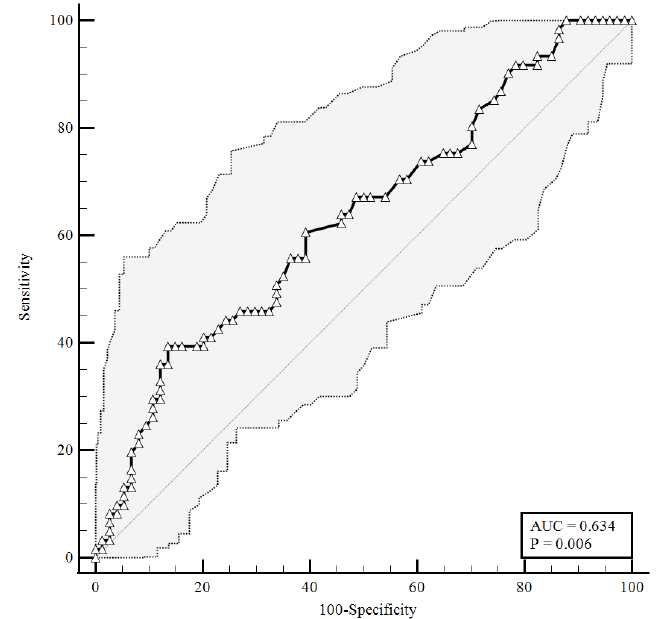
Figure 3. ROC curve for plasma CGRP levels upon hospital admission predicting pulmonary vascular events development. AUC = area under the curve, p = p -value.